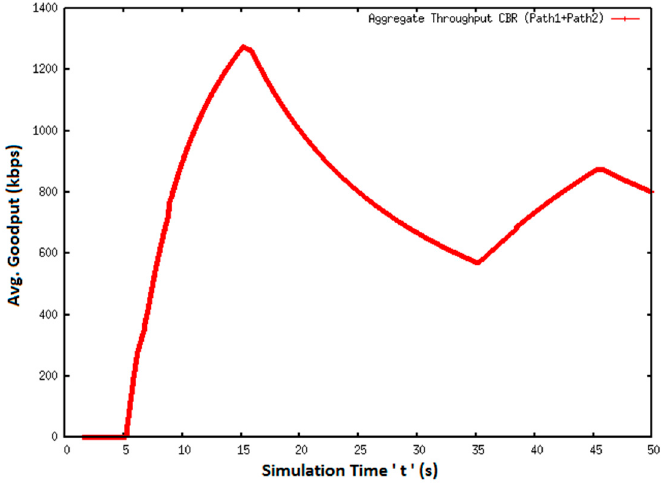
Figure 4. Constant bit rate (CBR) traffic generator start stop pattern for each path with CBR data rate 1 Mbps.